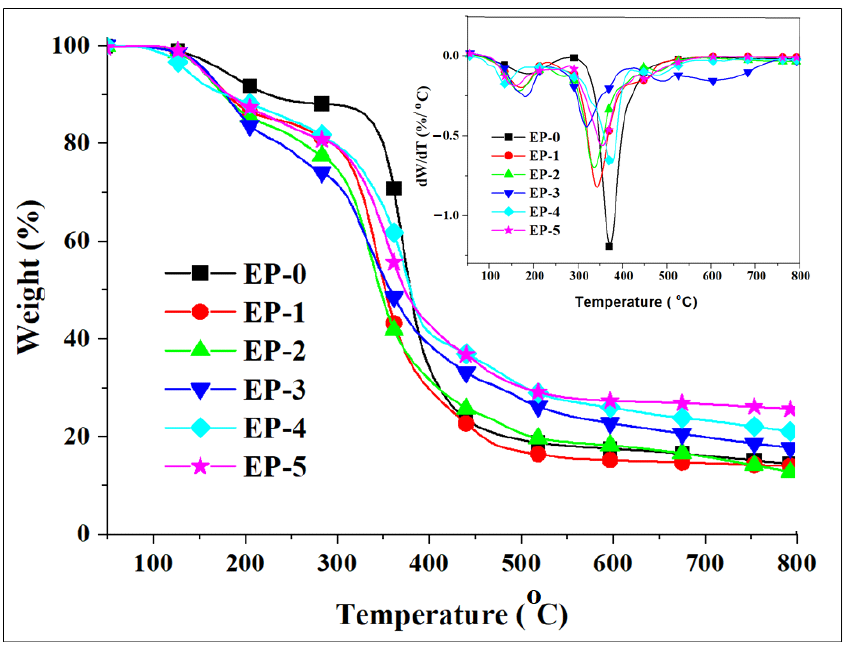
Figure 7. TG and DTG curves (inset) of epoxy composites. Table 2. Thermal properties of epoxy composites.